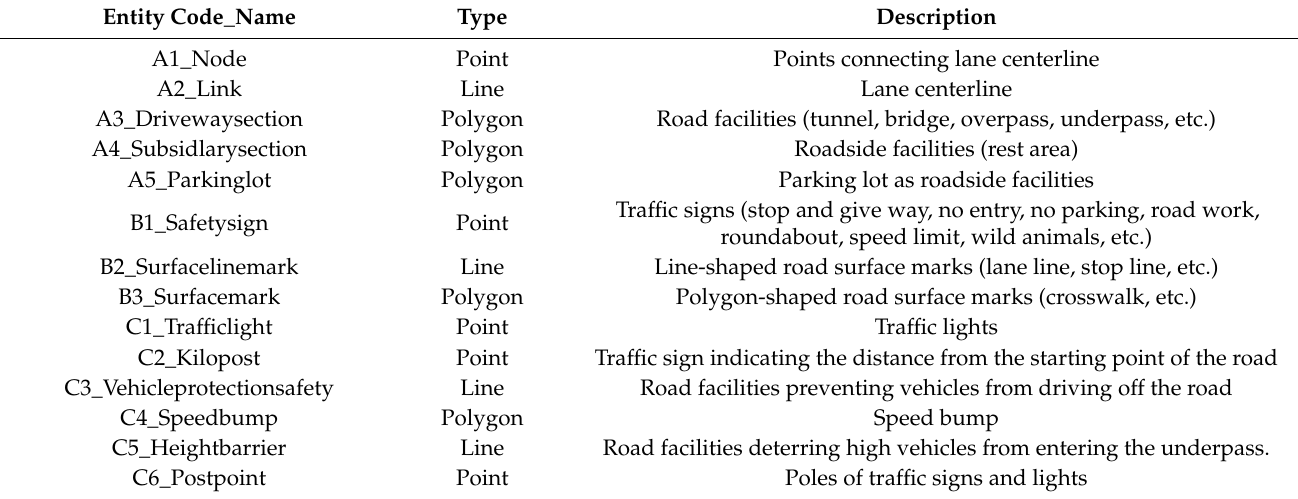
Table 6. Latest revision of NGII vector map format (adapted from